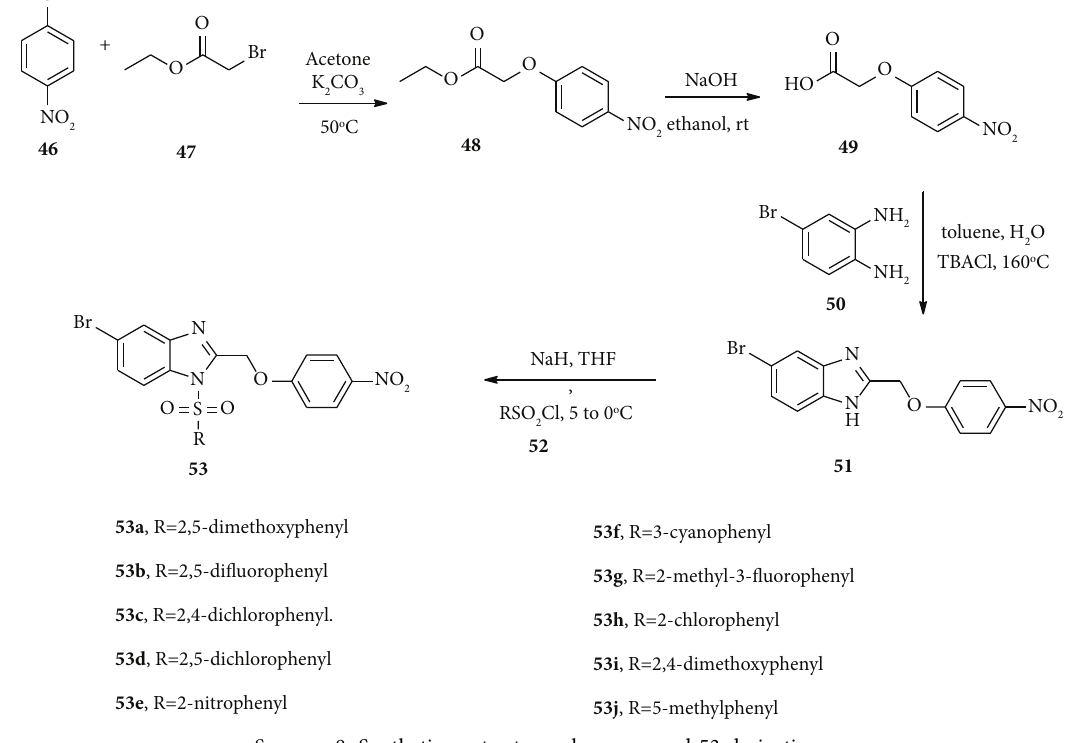
Scheme 8: Synthetic routes towards compound 53 derivatives.